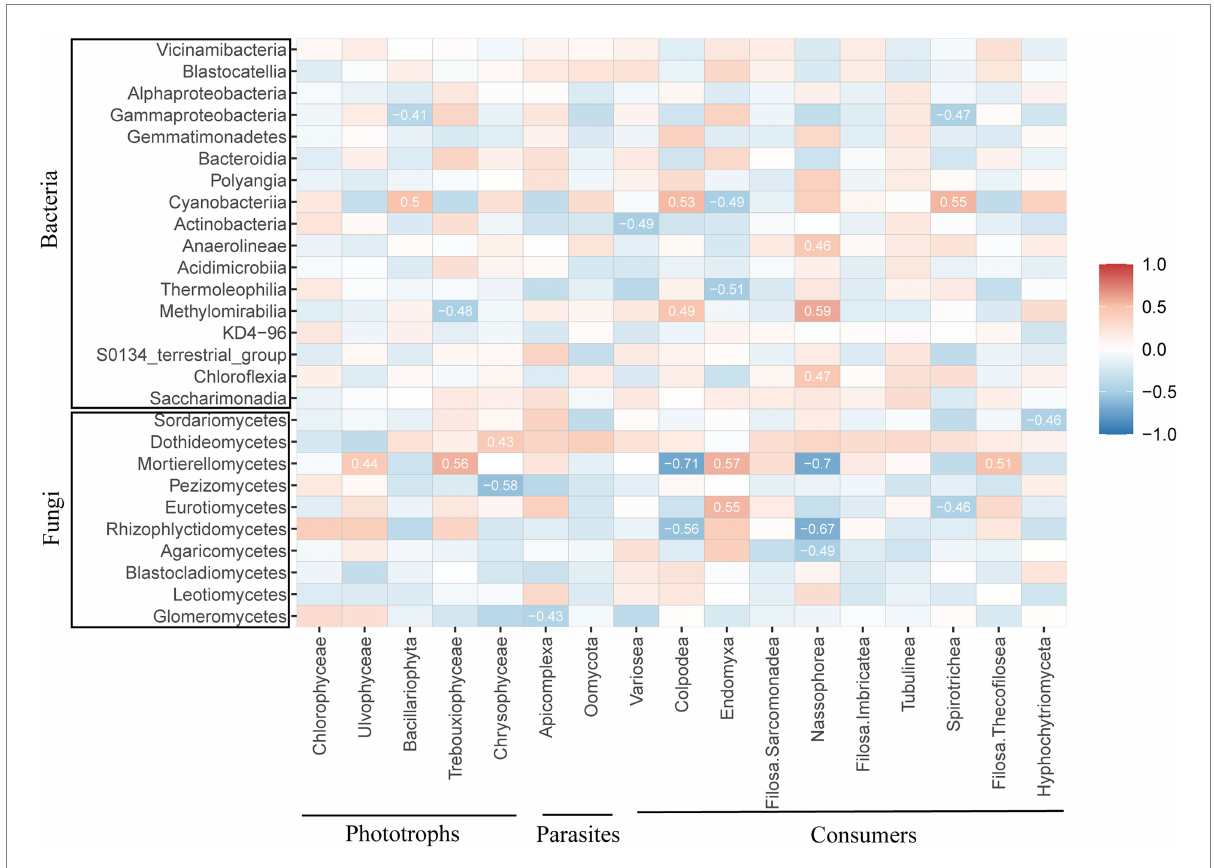
FIGURE 4 Correlation analysis of the relative abundance of protists with bacteria and fungi at the class level. Blue indicates a negative correlation, red represents a positive correlation, and the strength of the color reflects the strength of the